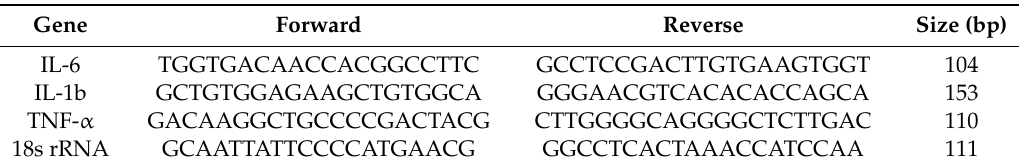
Table 2. List of